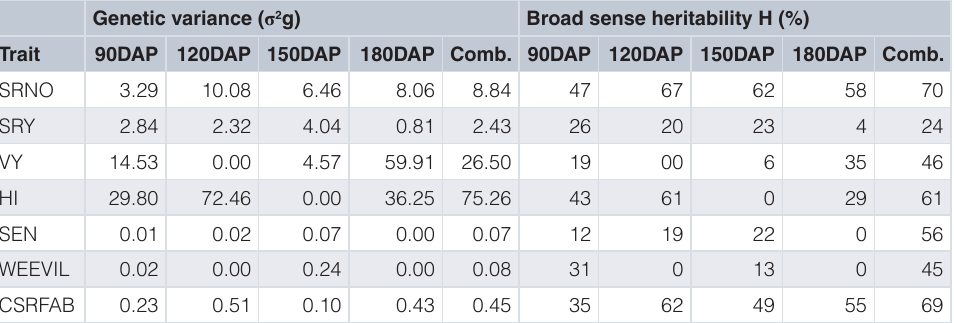
Table 6. Estimates of genotypic ( σ 2 g) variance and broad sense heritability (H) within harvest time across environments for seven traits associated with continuous storage root formation and